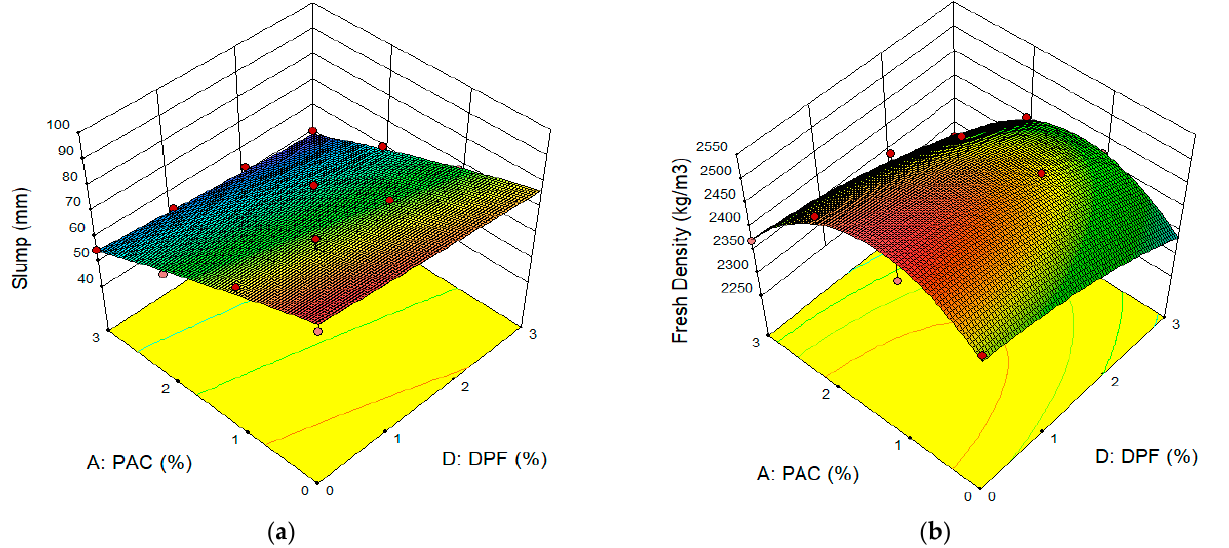
Figure 6 . Surface Plots for Slump and Fresh Density . ( a ) Slump, ( b ) Fresh